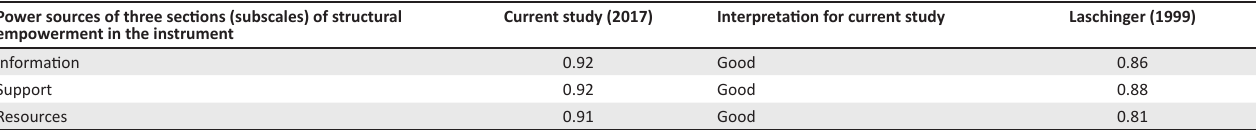
TABLE 1: Cronbach’s alpha coefficient (α). Conditions of Work Effectiveness Questionnaire. Power sources of three sections (subscales) of structural empowerment in the instrument